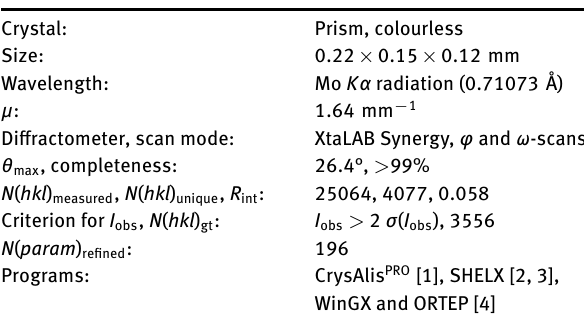
Table 1: Data collection and